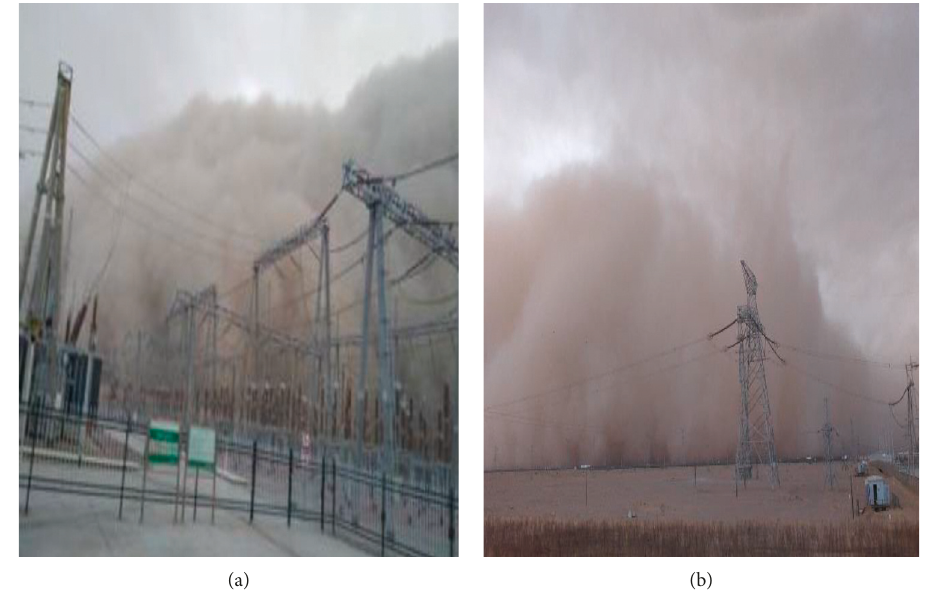
Figure 1: Facilities of the power grid subjected to a sandstorm: (a) power substation; (b) tower-line